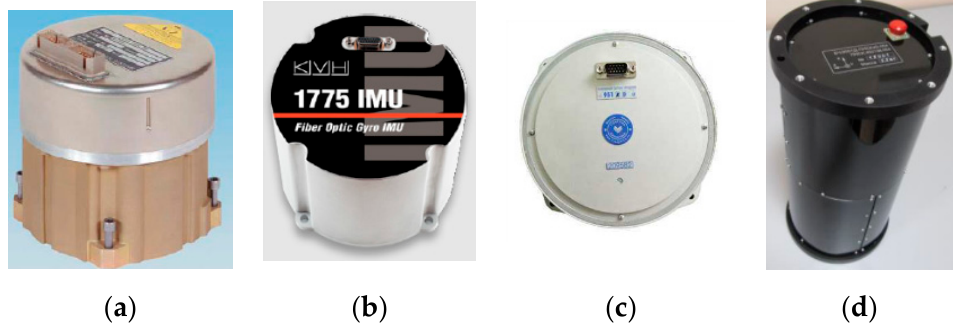
Figure 5. Fiber Optic Gyroscope (FOG) Inertial Measurement Units (IMUs) for intelligent PIG surveying. ( a ) LN-200 IMU. ( b ) 1775 IMU. ( c ) VG-951 FOG. ( d ) IMU-501D.